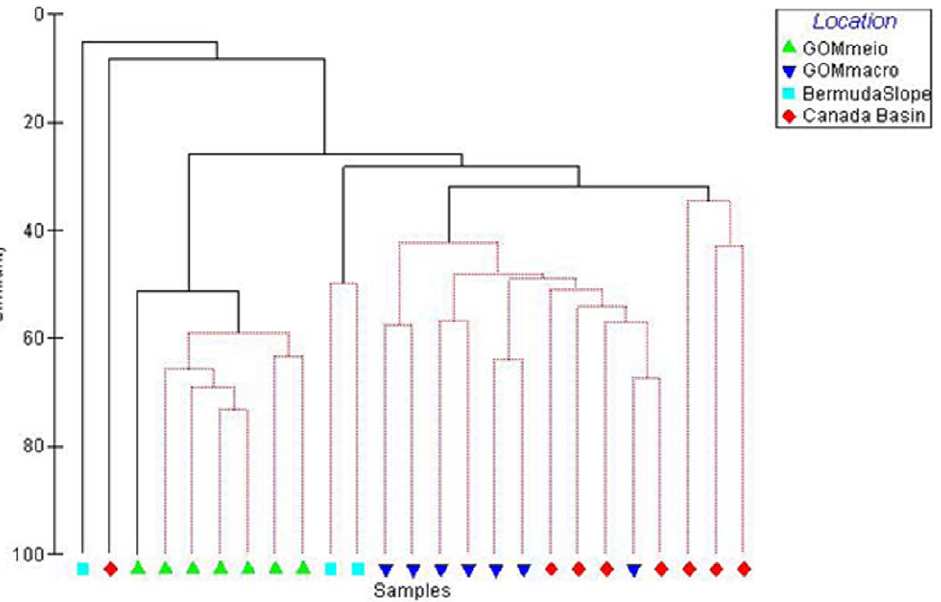
Figure 3. Hierachical cluster analysis with SIMPROF test on similarity of nematode genera from meio- and macrobenthos in the Canada Basin and the Bermuda transect based on presence/absence of genera.